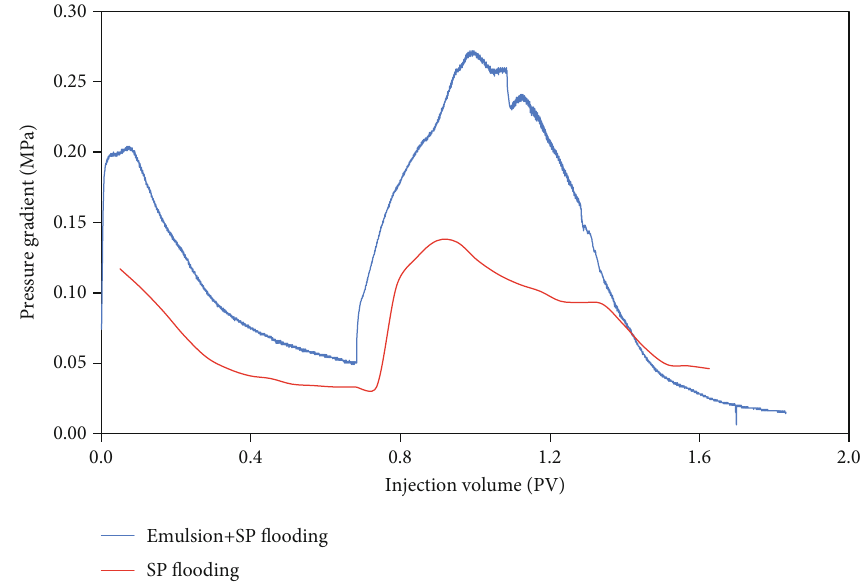
Figure 4: Pressure gradient curves of SP fl ooding and emulsion fl ooding following SP fl ooding.